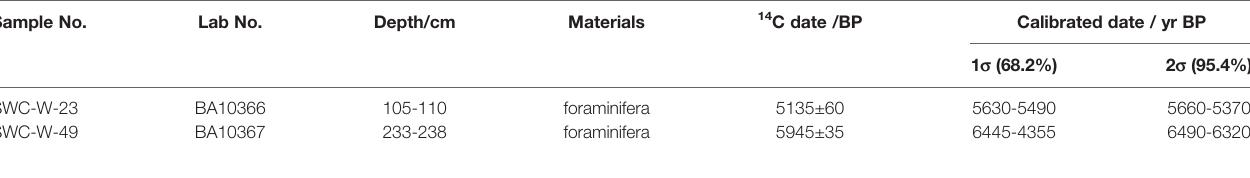
TABLE 1 | 14 C ages of mixed benthic foraminifera of the SWC-W pro fi le at the SWC site. Sample No.